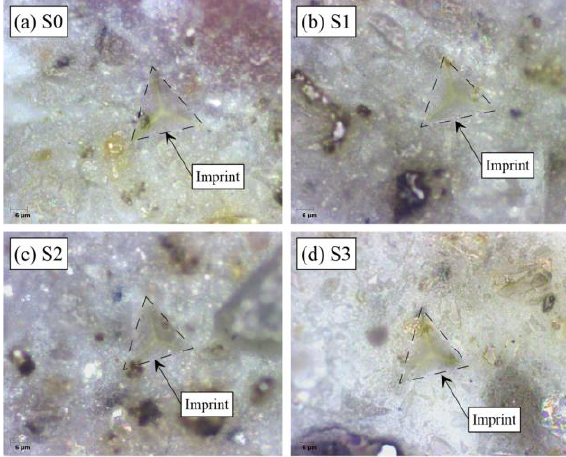
Figure 7. Exemples of indentation imprints for samples of the series ( a ) S0, ( b ) S1, ( c ) S2, and ( d )